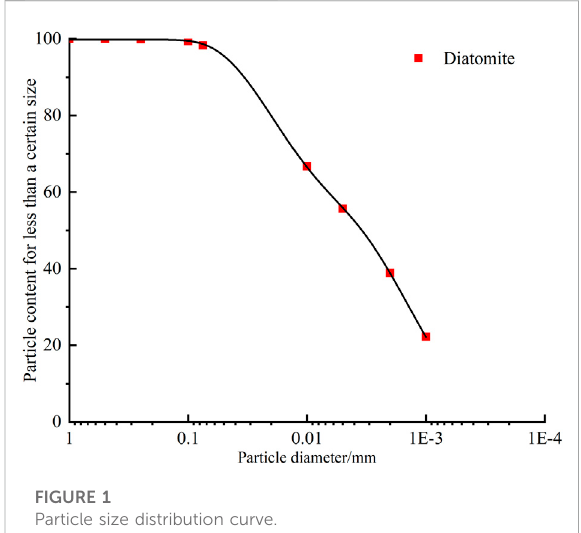
FIGURE 1 Particle size distribution curve.